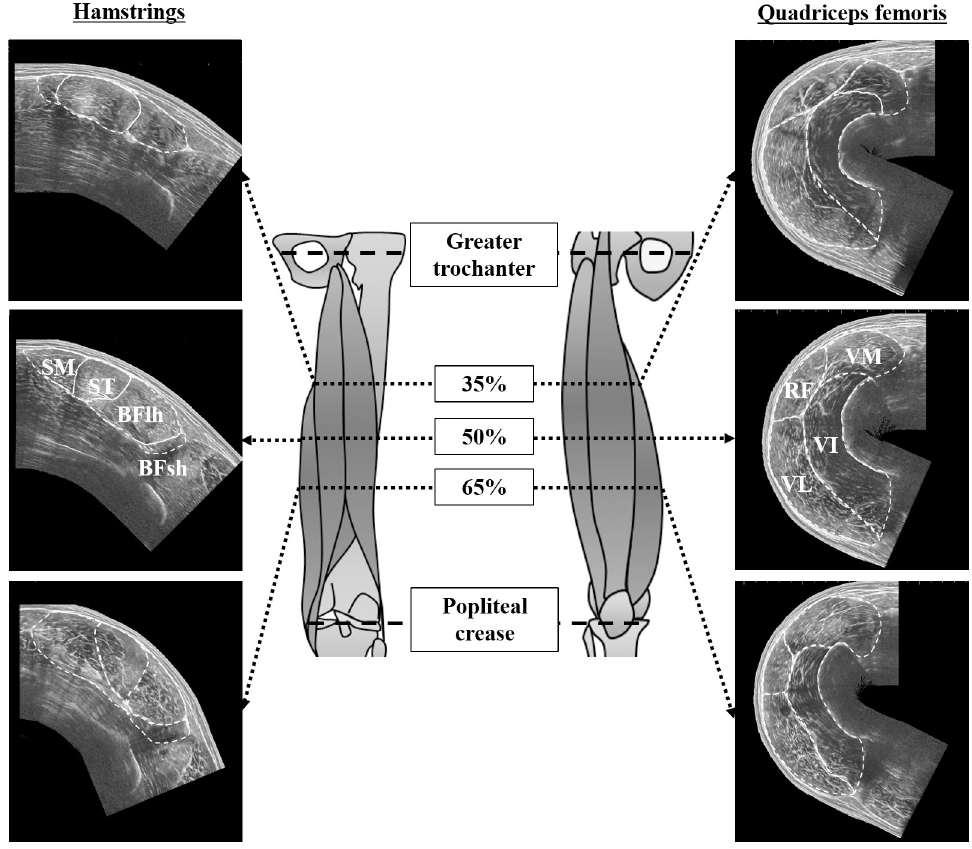
Fig 1. Measurement locations of the anatomical cross-sectional area and ultrasound images in the thigh muscles. The white broken line indicates the outline of the individual muscles of the hamstring and quadriceps femoris. BFlh, biceps femoris long head; BFsh, biceps femoris short head; ST, semitendinosus; SM, semimembranosus; RF, rectus femoris; VL, vastus lateralis; VM, vastus medialis; VI, vastus